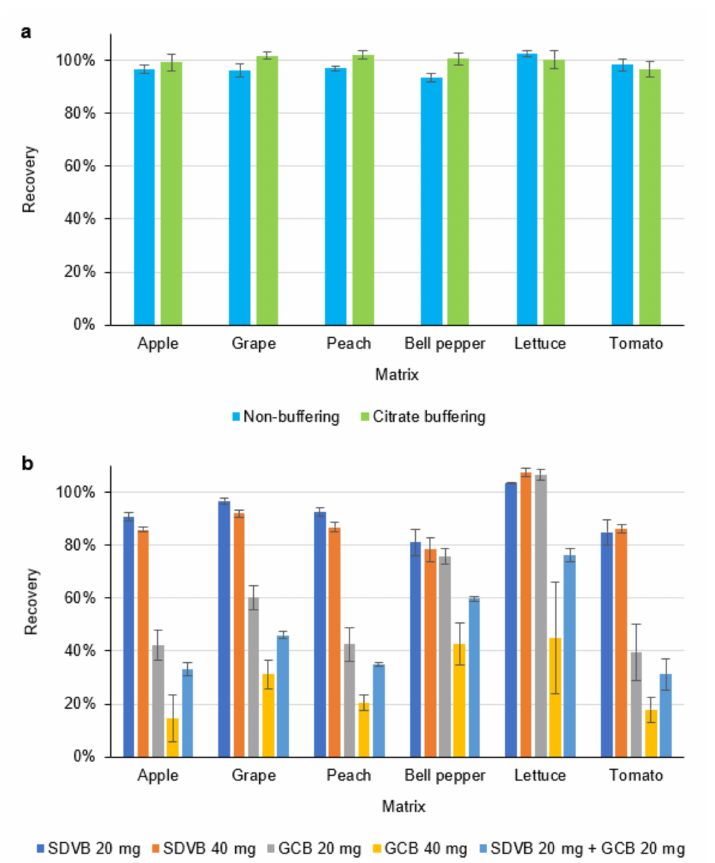
Figure 3. Effects of different extraction ( a ) and cleanup ( b ) strategies on recoveries of CYCP from fruit and vegetable